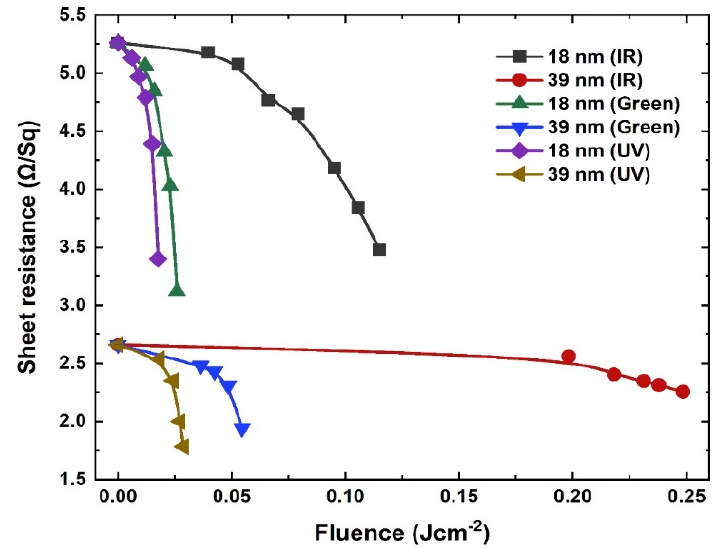
Figure 4. Decrease in sheet resistance as a function of applied laser fluence in an optimized regime before and after IR, green and UV laser scanning of 18-nm and 39-nm Au films, respectively.